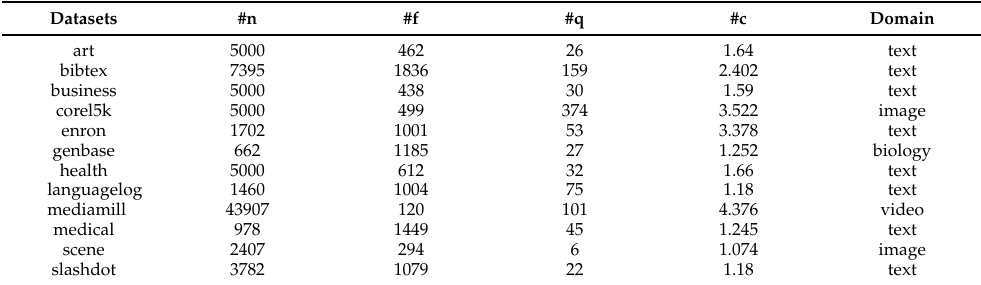
Table 1. Characteristics of